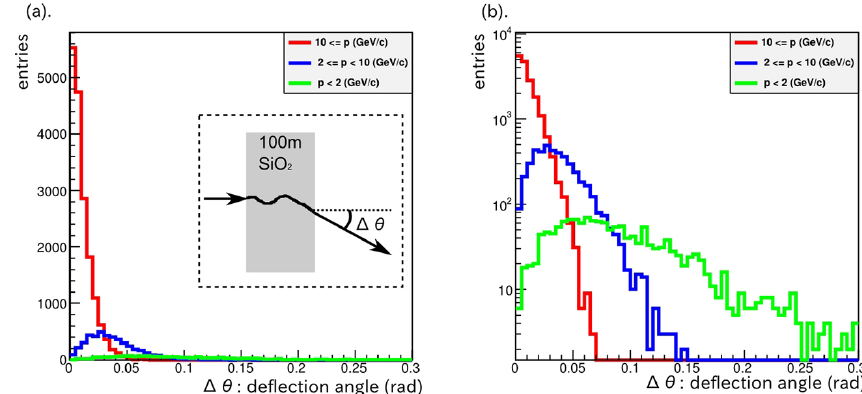
Fig. 1. Deflection angles of CR muons after passing through 100m thickness of quartz ( (a) linear scale, (b) logarithmic scale). The injection momenta are adjusted to the CR muon momentum spectrum for a zenith angle of 80 ◦ . The histogram is divided into three color parts based on the momenta of the ejected muons, green: p out < 2GeVc − 1 , blue: 2GeVc − 1 ≤ p out < 10GeVc − 1 , and red: 10GeVc − 1 < p out .